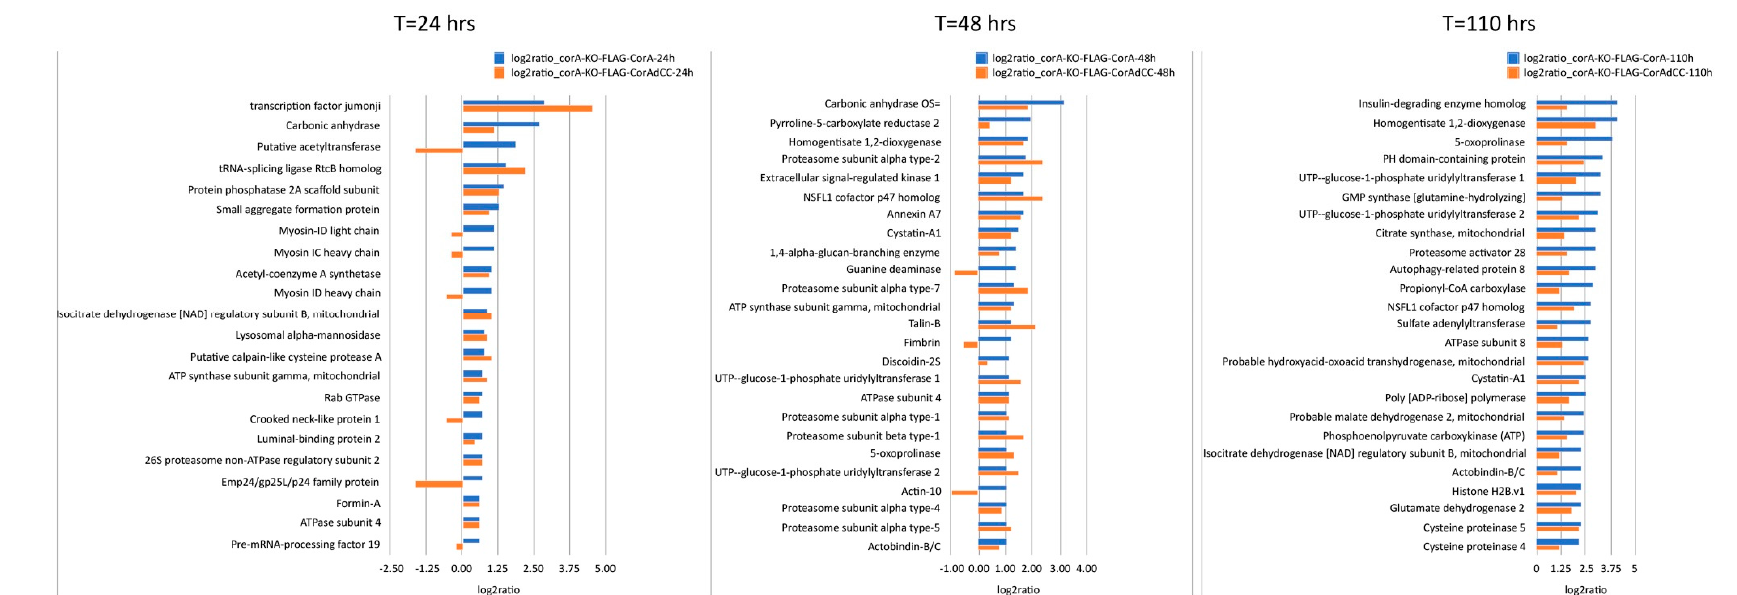
Figure 5. Time-dependent analysis of the coronin A interactome. Cells expressing either FLAG-CorA or FLAG-CorA ∆ CC were sampled at 24, 48 or 110 h, lysed, and subjected to AP-MS as described in Materials and Methods. The 25 most significant interactors (log2ratio > 1; q -value < 0.05) are shown. For clarity, proteins with unknown function are not represented. Note that the expression of FLAG-CorA ∆ CC is ~40-fold enriched relative to FLAG-CorA. See also Table S1.